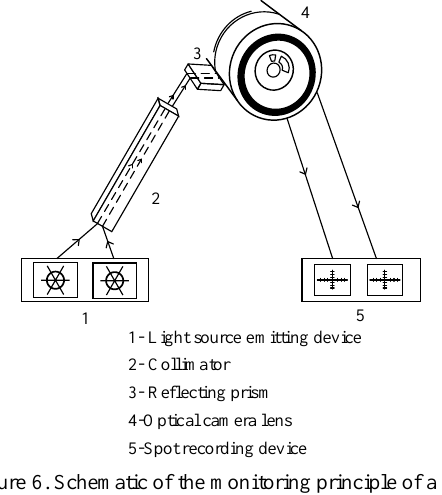
Figure 6. Schematic of the monitoring principle of a single camera’s optical